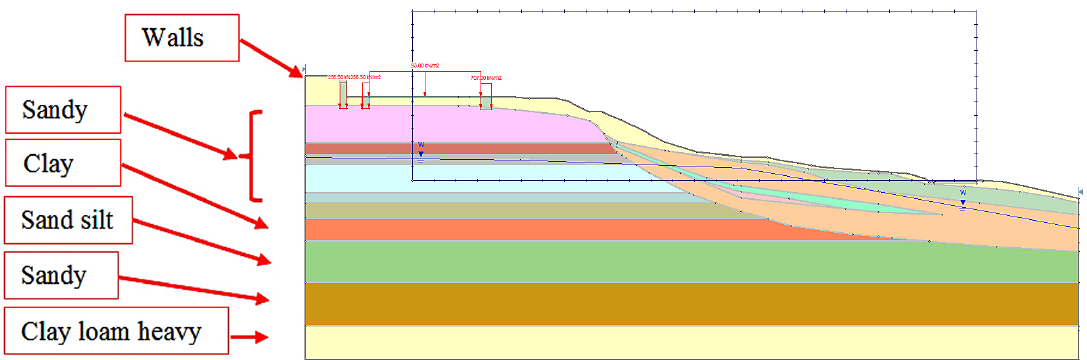
Figure 5. The model used to define the slope stability in the computational complex RocScience Slide.